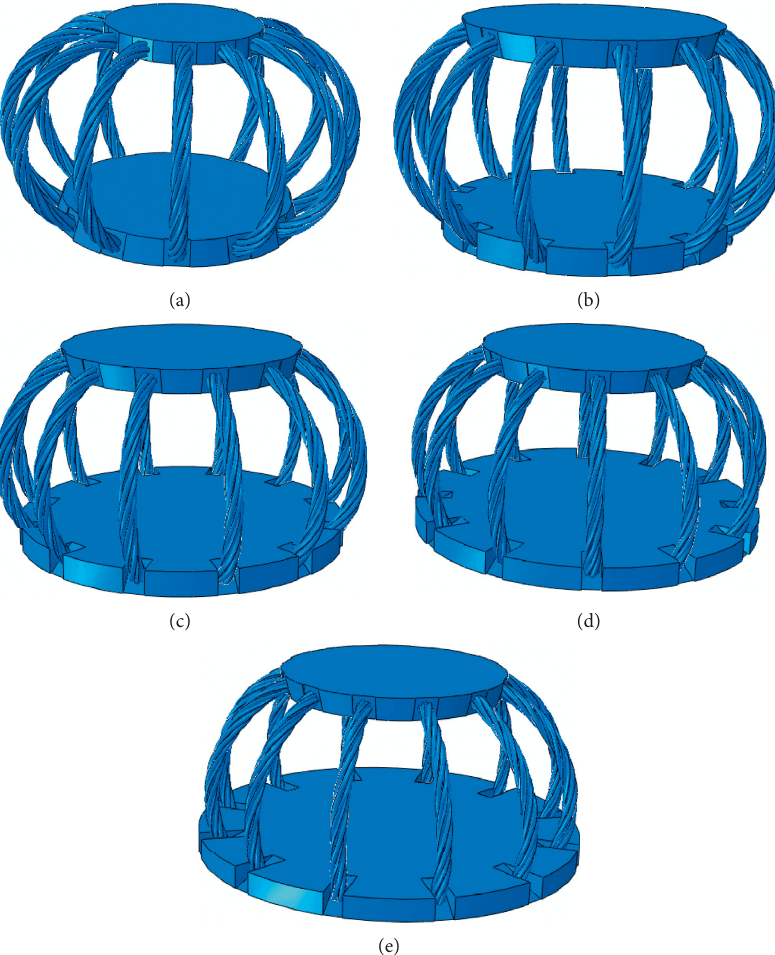
Figure 10: GGQ-99 WRIs with different bending radii. (a) 46.5mm. (b) 50mm. (c) 55mm. (d) 60mm. (e)